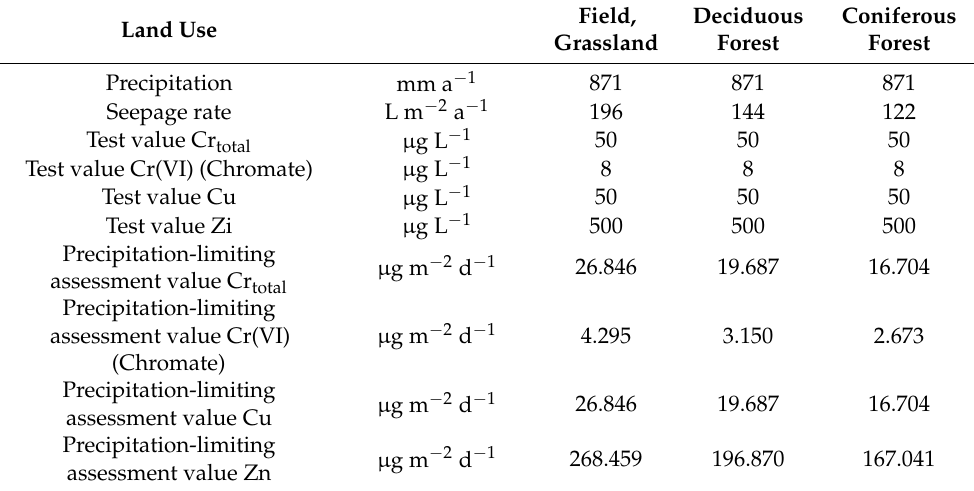
Table 16. Rough estimate of the precipitation-limiting assessment values for the protection of groundwater as a drinking water reservoir in